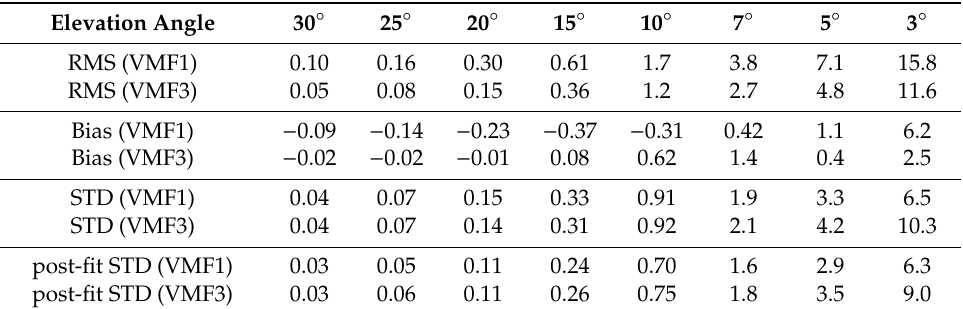
Table 5. Mean RMS, biases, and standard deviations (STD) of the di ff erences between the hydrostatic